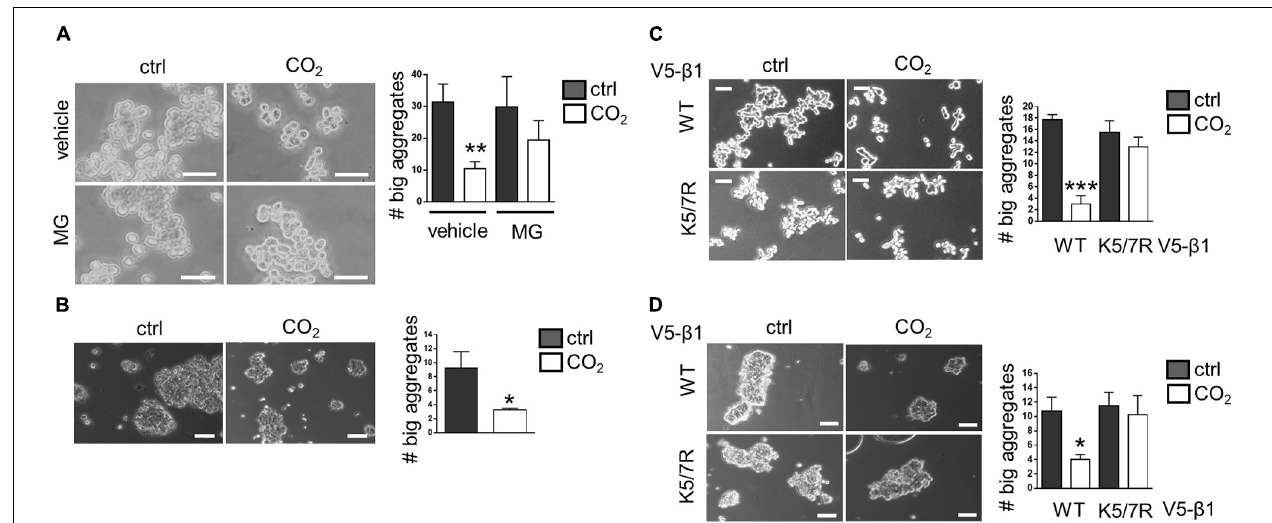
FIGURE 5 | Expression of the K5/7R Na,K-ATPase β -subunit restores hypercapnia-impaired alveolar epithelial cell-cell junction formation. (A) A549 cells were exposed to 40 or 110 mmHg CO 2 at a pH of 7.4 for 8 h. The number of aggregates containing more than 10 cells was determined. Mean ± SEM, n = 4, unpaired t -test, ** p < 0.005. Scale bar = 50 µ M. (B) A549 cells were exposed to 40 or 110 mmHg CO 2 at a pH of 7.4 for 4 h. The number of aggregates containing more than 20 cells was determined. Mean ± SEM, n = 3, unpaired t -test, ** p < 0.005. Scale bar = 50 µ M. (C) A549 nucleofected with V5- β 1 wt or V5- β 1 K5/7R were exposed to 40 or 110 mmHg CO 2 at a pH of 7.4 for 4 h. The number of aggregates containing more than 20 cells was determined. Mean ± SEM, n = 3, unpaired t -test, *** p < 0.0005. Scale bar = 50 µ M. (D) Rat primary ATII cells nucleofected with V5- β 1 wt or V5- β 1 K5/7R were exposed to 40 or 110 mmHg CO 2 at a pH